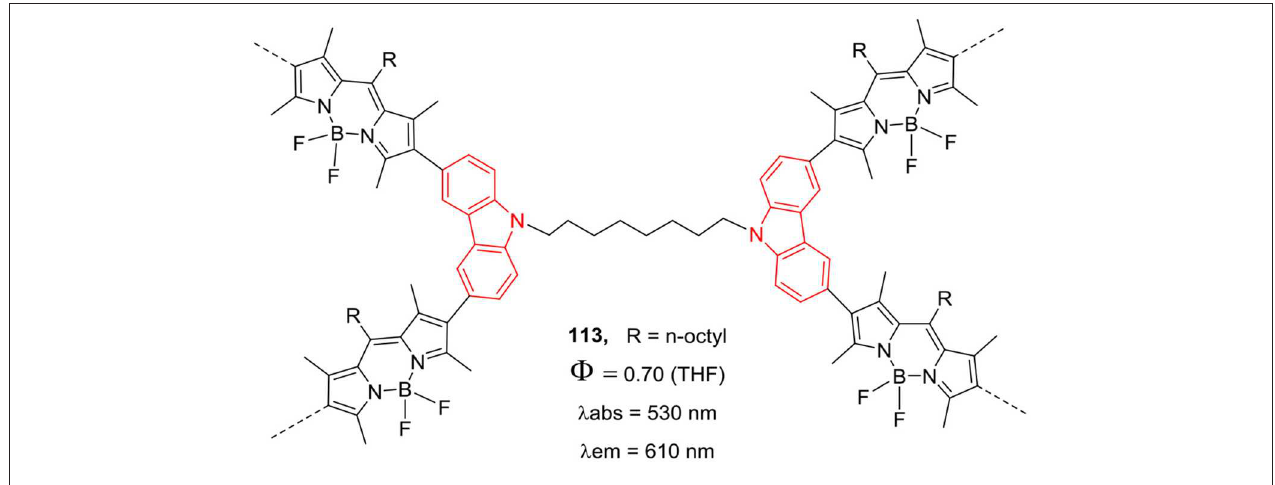
CHART 17 | Synthesis of carbazole-BODIPY based soluble polymer.